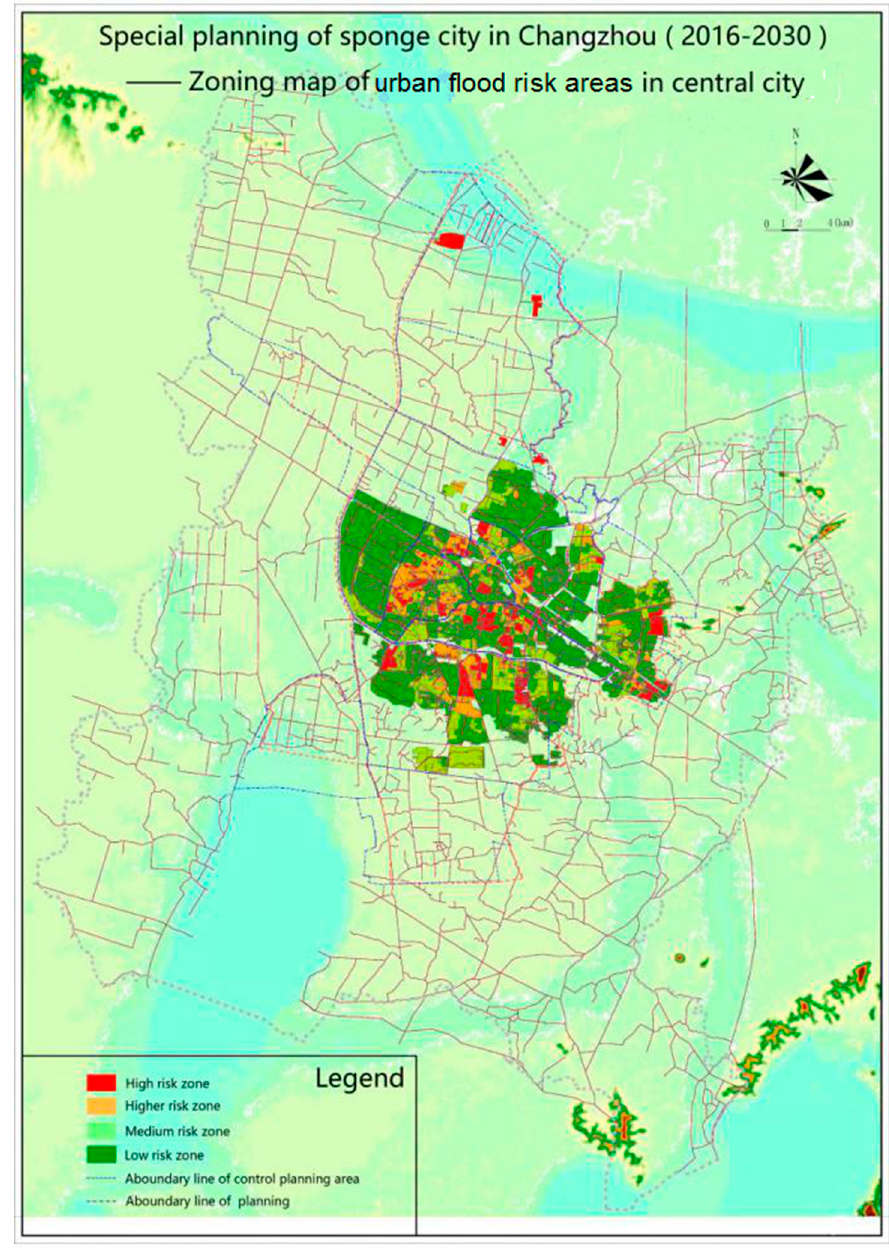
Figure 5. Map displaying the flood risk spots in the central urban area in Changzhou.